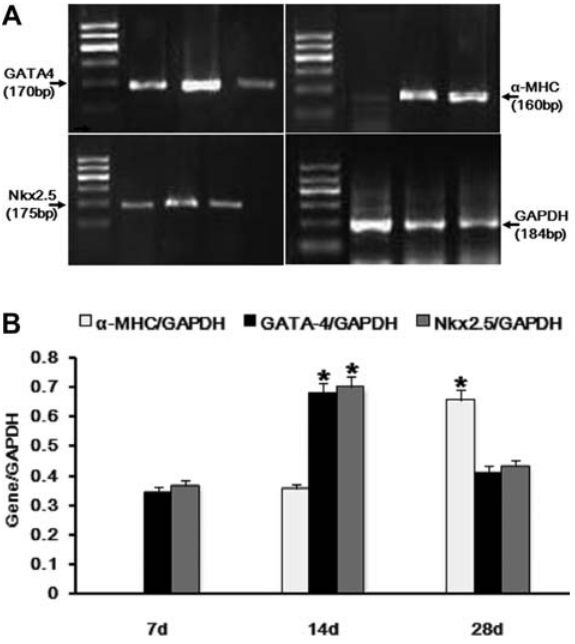
Figure 4. Expression of mRNA for GATA-4 , Nkx2.5 , a -MHC in rat bone marrow mesenchymal stem cells treated with 5 ng/mL TGF- b 1. A , Expression of mRNA by electrophoresis on 2% agarose gel. B , Bar graph showing the semi-quantitative expression of mRNA for GATA-4 , Nkx2.5 and a -MHC , for the 28-day experi- ment. Data are reported as means ± SD. *P o 0.05 vs 7d (one-way